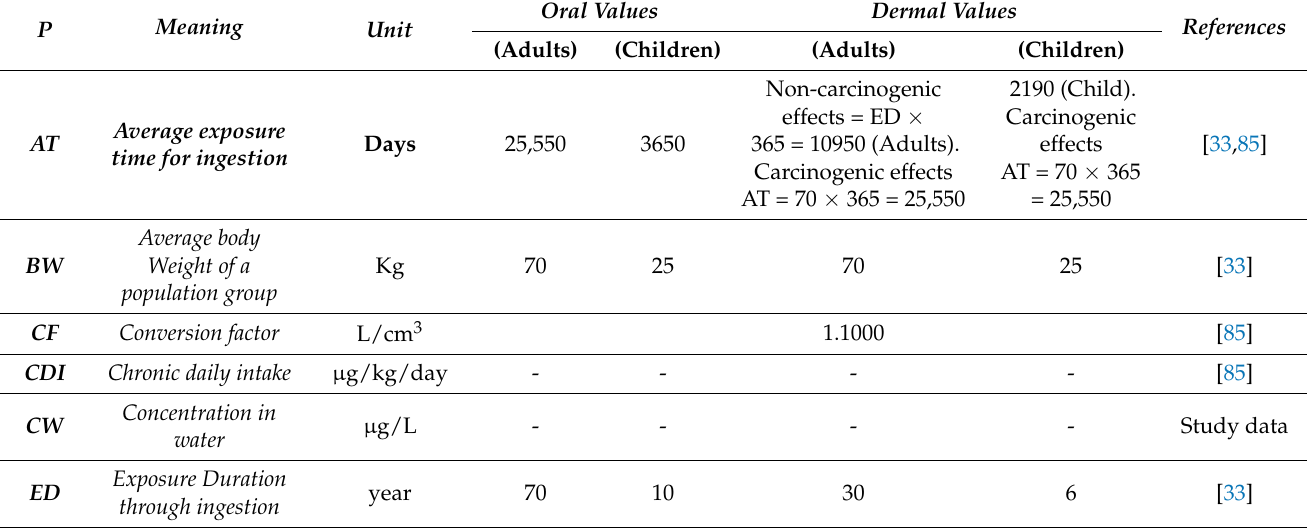
Table A2. Definitions, symbols, units, and values associated with equations used for health risk